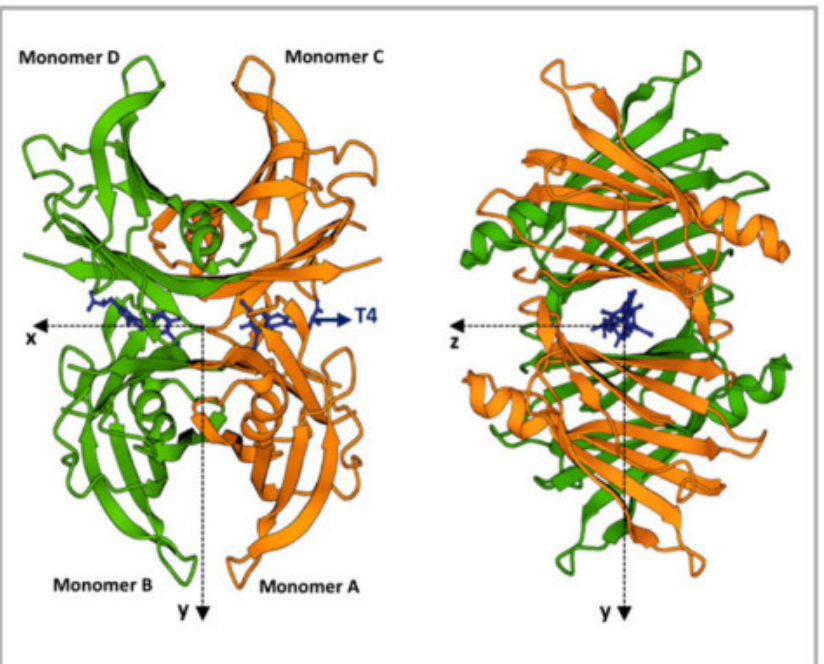
Figure 1. TTR structure. Ribbon diagram of the TTR tetramers. The X-axis passes through the T4 binding channels, which are formed at the interface of monomers D-B and C-A. T4 is represented in blue. The figure was produced using the “www.rcsb.org” website (protein ID code 1QAB), access date 22 June 2022. Modified with permission from C. Sanguinetti et al., 2022 [14].